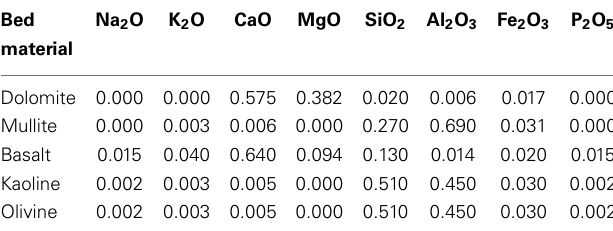
Table 4 | Composition of tested alternative bed materials (kg/kg)